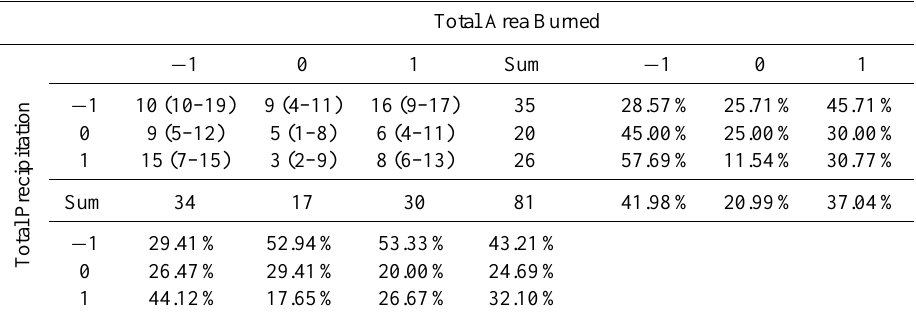
Table 4. Cross-tabulation results between area burned and total annual precipitation. The Monte Carlo randomization confidence limits are in